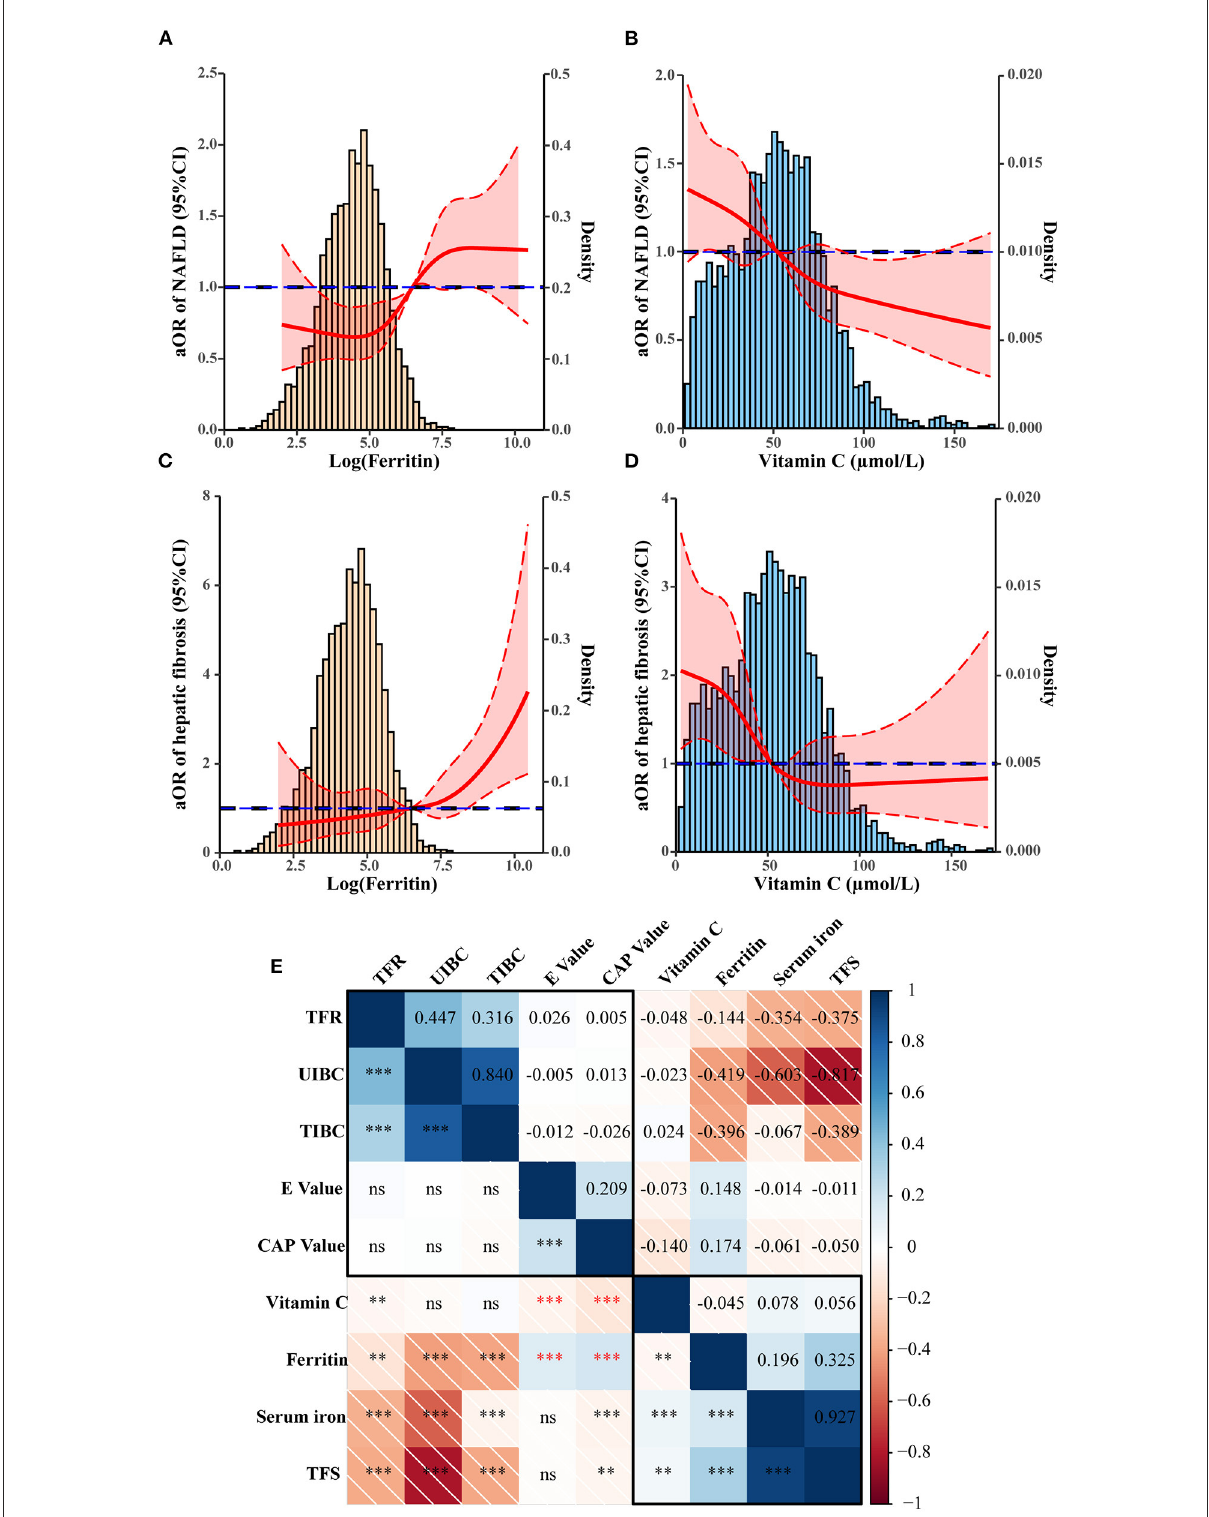
FIGURE2 Association between Vit C, ferritin, and NAFLD. (A,B) Restricted cubic spline (RCS) showing the relationship between Ferritin and Vitamin C with adjusted odds ratio of NAFLD (solid line). (A,C) Ferritin, (B,D) Vitamin C. The 95% confidence interval is indicated by the dashed line area. (E) Correlation between iron metabolism, Vitamin C, and liver ultrasound transient elastography value. ** p < 0.01, *** p <